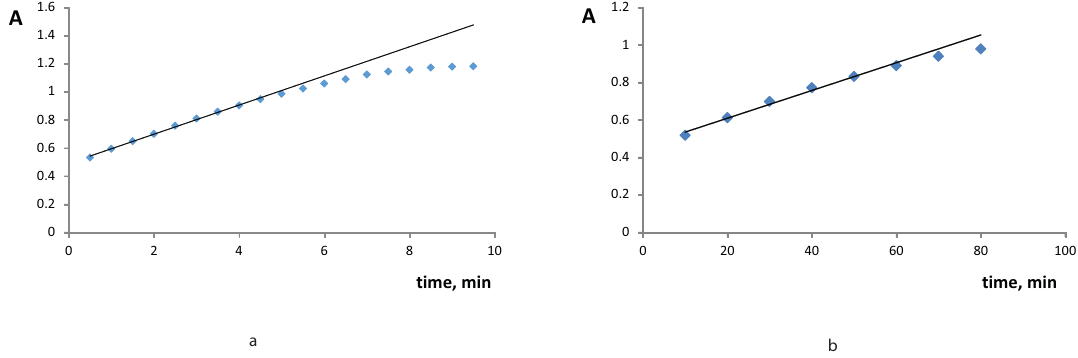
Figure 2. The increase of absorbance with time for 1.0 × 10 − 3 M l -DOPA ( a ) and l -tyrosine ( b ). pH 7.2, ABE activity 265 U ( a ) and 530 U ( b